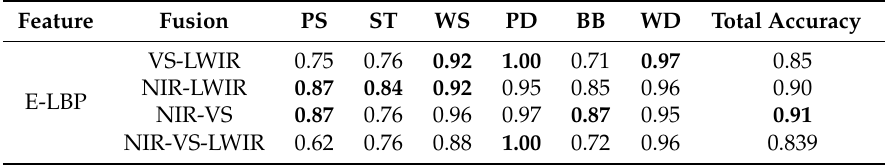
Table 4. Classification performance using E-LBP/BOW and late fusion (PS = Paper scraps, ST = Stains, WS = White spots, PD = Paper displacements, and BB = Bubbles, WD = Without defect).